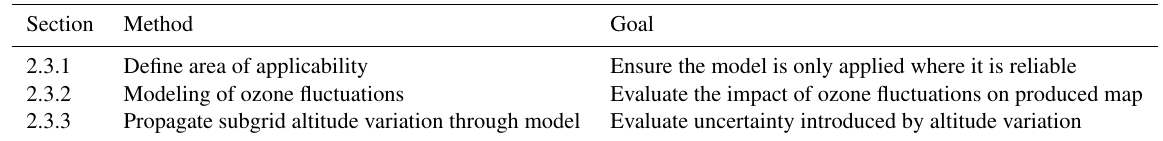
Table 3. Uncertainty assessment for our mapping method. For details on the methods, refer to the given sections. Section